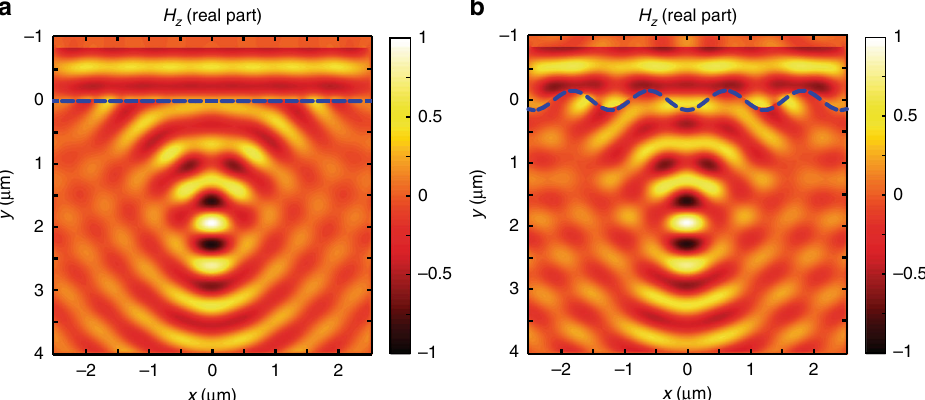
Fig. 4 From fl at to curved meta-lenses. Magnetic fi eld intensity distribution of light transmitted through a planar a and a free-form b lens with focal of 2.5 μ m. In the calculations, the incident light is a TM polarised plane wave propagating along the y -direction. Blue dashed lines indicate the interfaces. These results show that conformal boundary optics is successfully implemented in a modi fi ed FDTD numerical scheme. It offers rapid numerical testing of free-form optical devices in view of their optimisation and benchmarking with planar metasurface